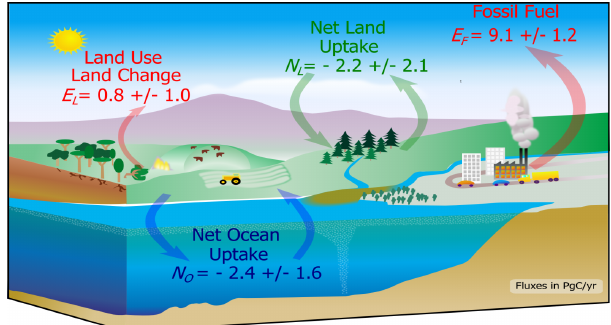
Figure 1. Diagram of the global carbon budget in the year 2010. Major fluxes of C to the atmospheric reservoir of CO 2 are from fossil fuel emissions ( F F ) and land use land conversion ( F L ) and are illustrated as red vectors. Net land ( N L ) uptake of C from the reservoir of atmospheric CO 2 is illustrated by green vectors and net ocean uptake ( N O ) is illustrated by blue vectors. The size of the vectors is proportional to the mass flux of C as indicated in petagrams of C per year, where 1Pg = 10 15 g (illustration modified from Wikimedia Commons). Error estimates for each flux in 2010 are expressed as ± 2 σ